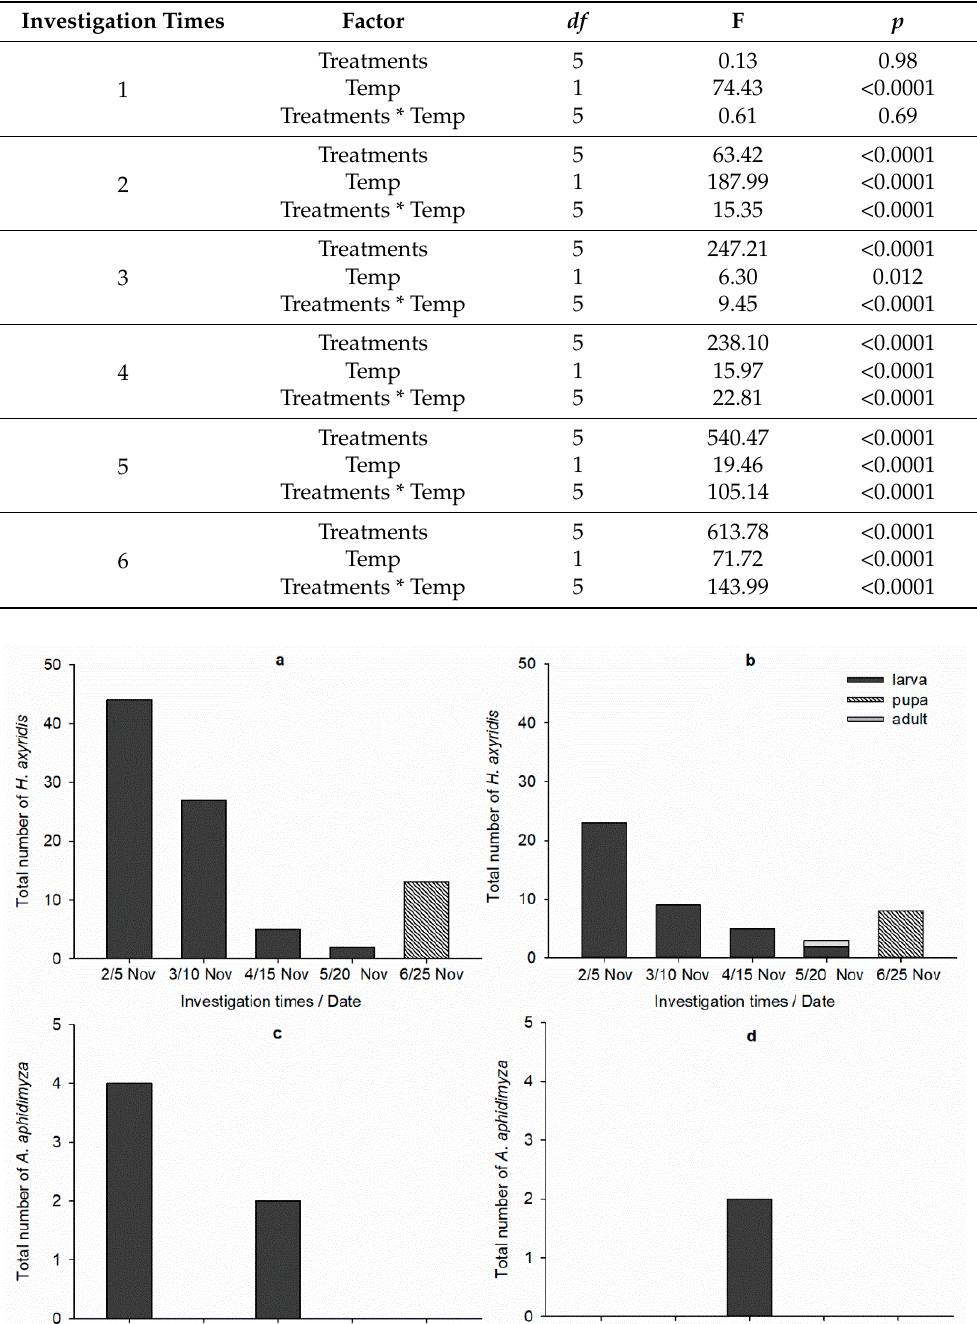
Table 6. Two-way ANOVA of treatments and temperatures on the population number of M. persicae .